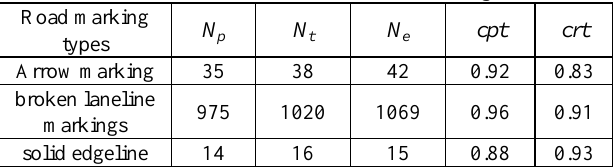
Table 2. Extraction results of road